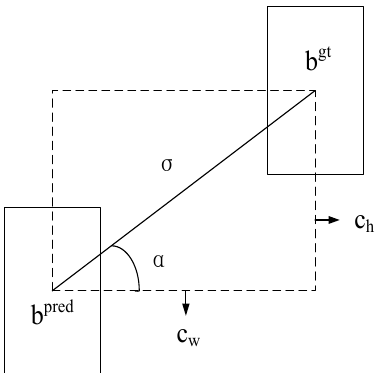
Figure 6. Diagram of SIoU loss